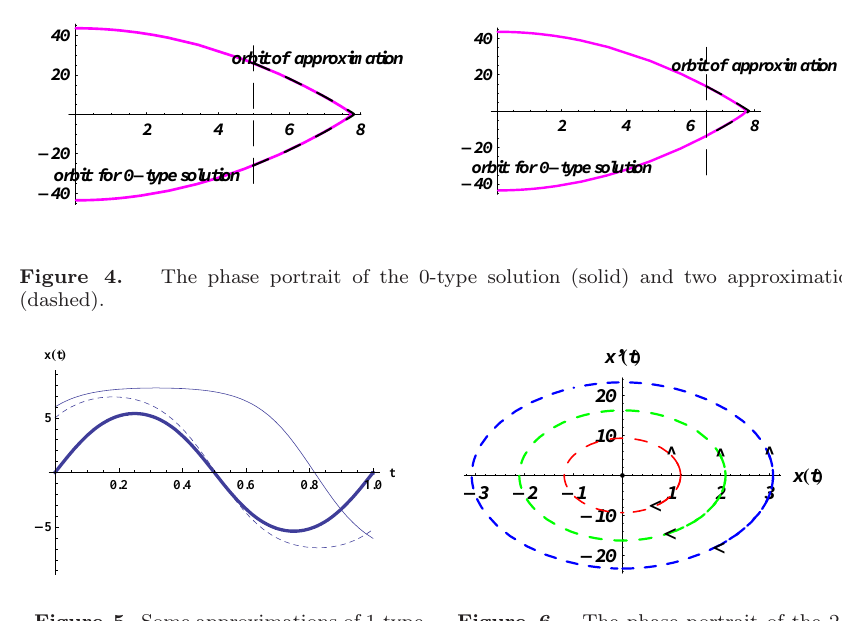
Figure 6. The phase portrait of the 2 - type solution (a point at the origin) and